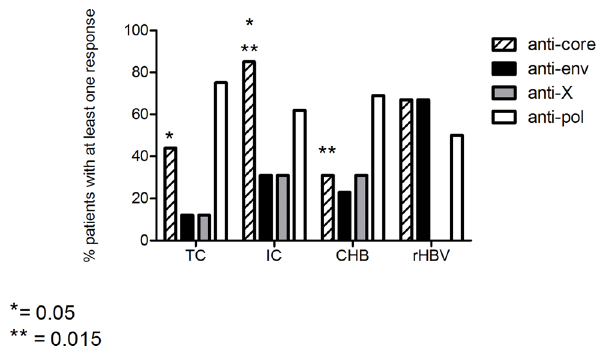
Figure 2. Percentage of patients with anti-HBV T cell response to the four HBV proteins in each subgroup. Percentage of patients in each clinical group with at least one response to the four different HBV proteins. Differences between percentage evaluated by Fisher’s exact test*=p value: 0.05. **=p value: 0.015.